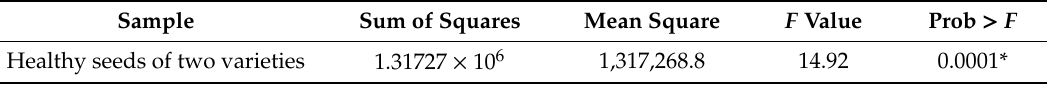
Table 1. Statistical parameter difference between healthy seeds of two different varieties.